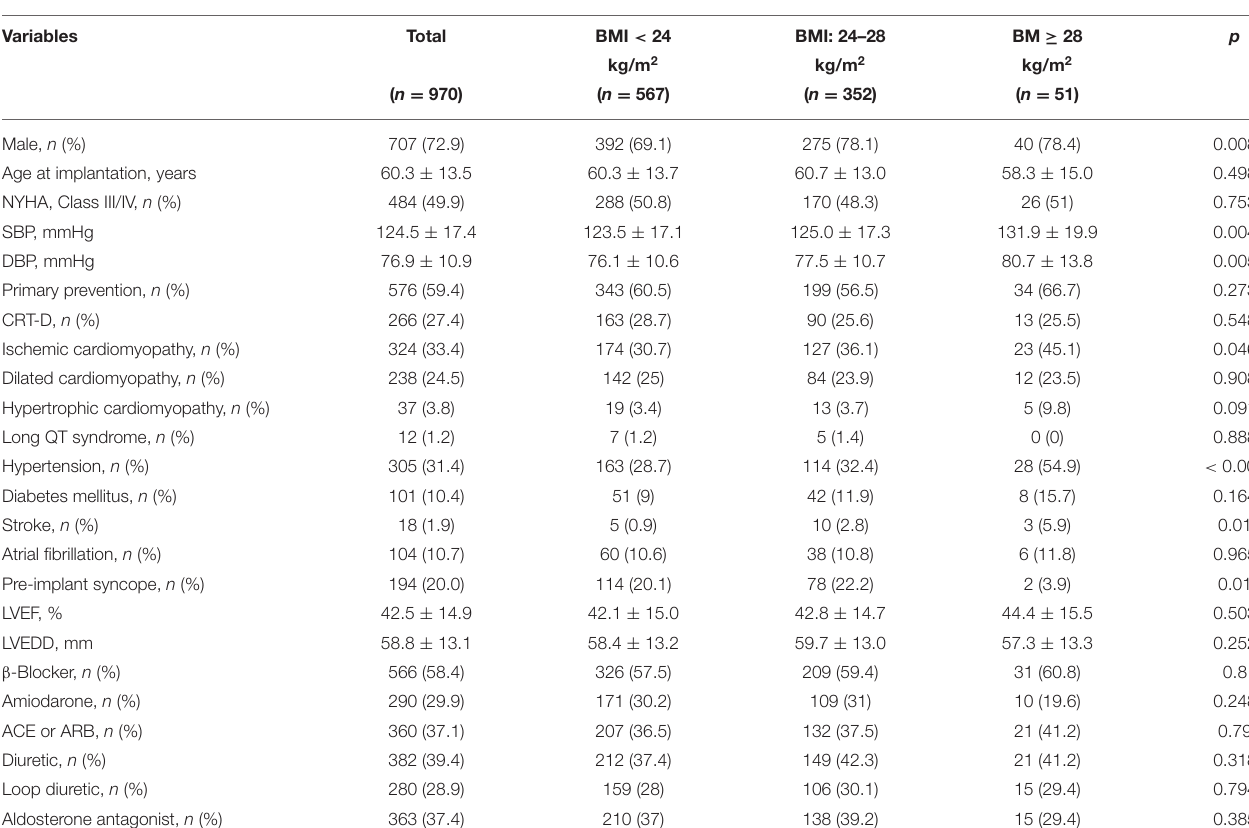
TABLE 1 | Baseline characteristics of study